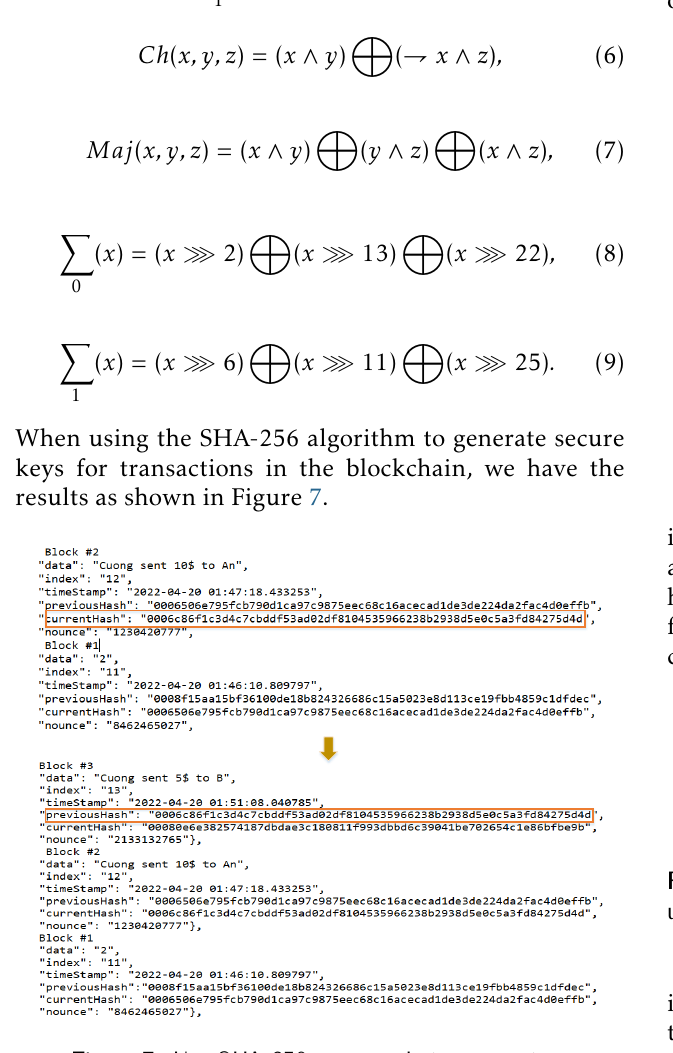
Figure 7. Use SHA-256 create code in transactions